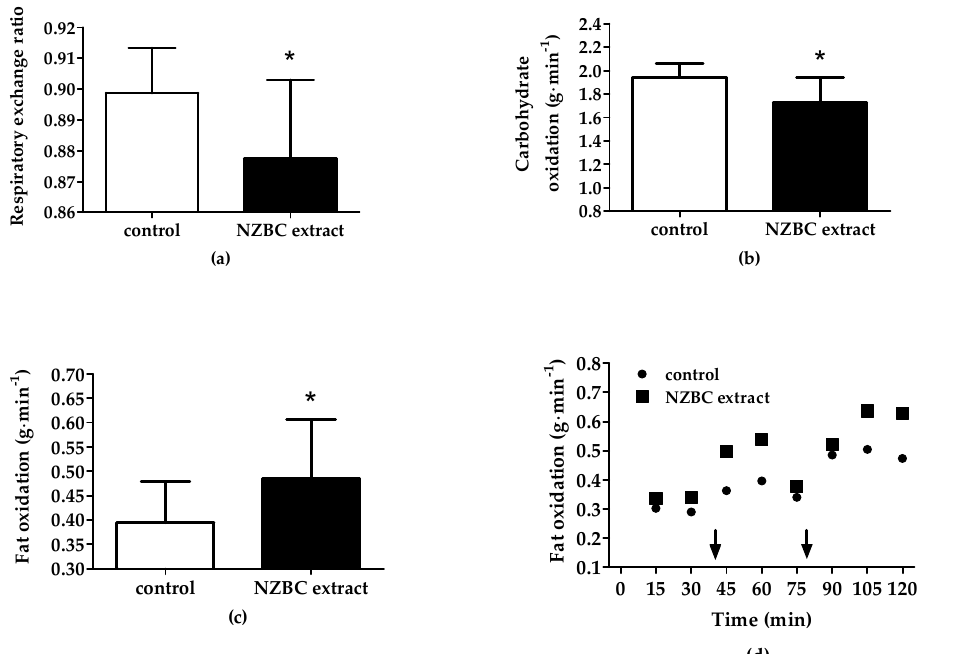
Figure 1. Respiratory exchange ratio ( a ), carbohydrate oxidation ( b ) and fat oxidation ( c ) during the 2 h treadmill run and fat oxidation at 15 min time points during the 2 h treadmill run ( d ). Data in ( a – c ) reported as mean ± SD from the 15 min time point recordings. Arrows in ( d ) indicate intake of the 100 kcal energy gels. NZBC, New Zealand blackcurrant, * indicates a difference with control ( p < 0.05).